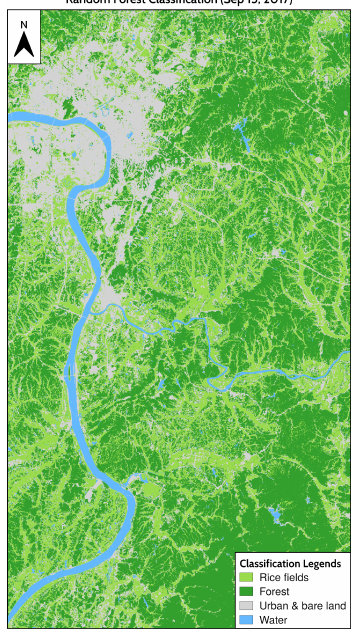
Figure 7. Spatial distribution of rice fields.